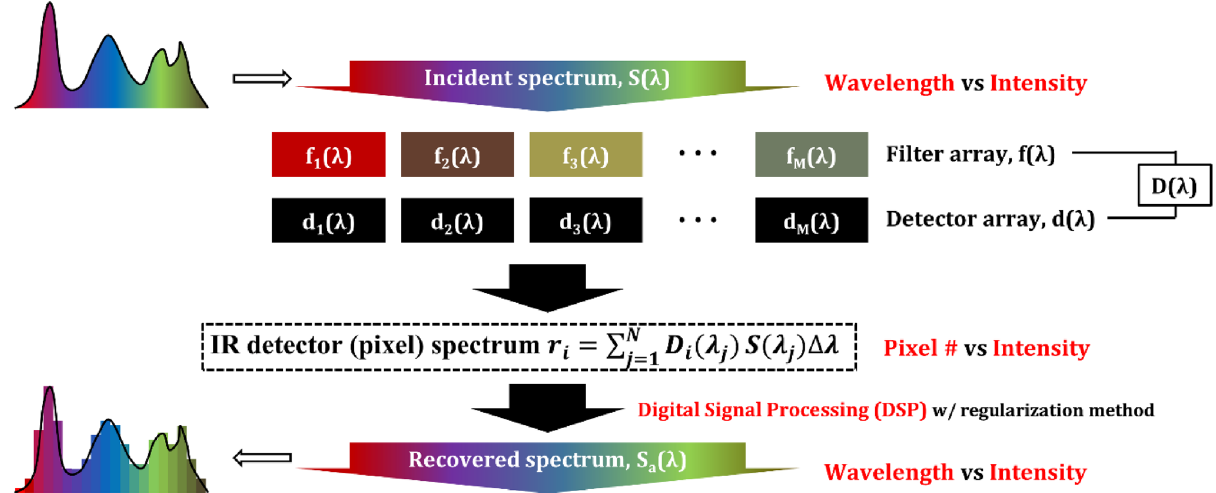
Figure 6. A schematic diagram illustrating the signal formation and spectral reconstruction process in the filter-array-based